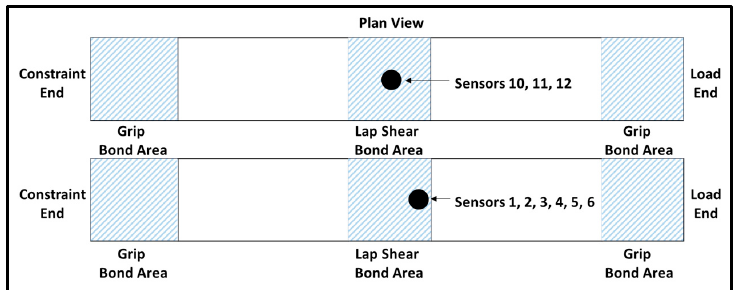
Figure 10. Test coupon-embedded sensor locations.